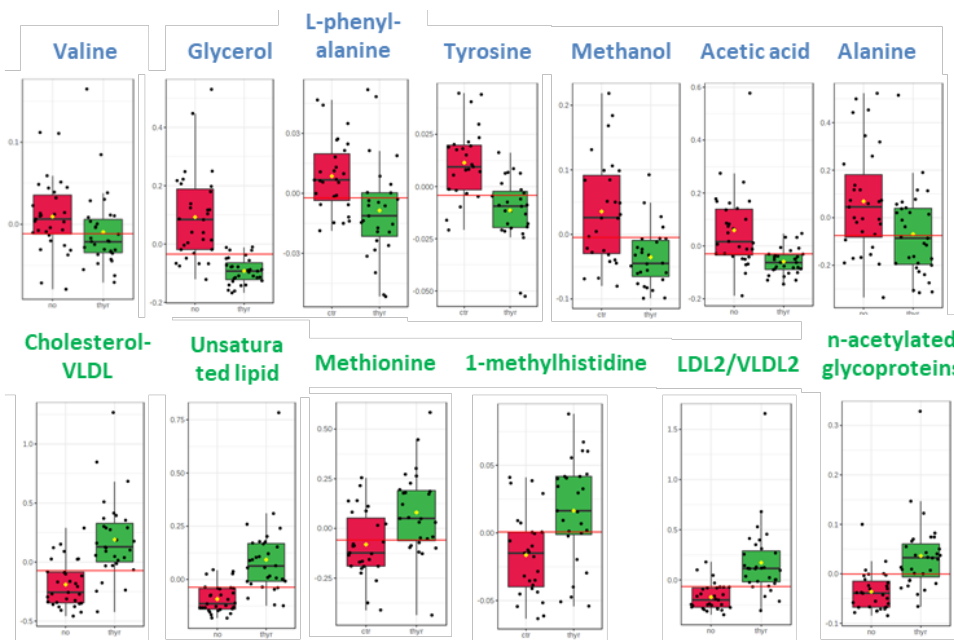
Figure 2. Box plots of discriminant metabolites in serum. (1. Valine, 2. Glycerol, 3. L-phenylalanine, 4. Tyrosine, 5. Methanol, 6. Acetic acid, 7. Alanine, 8. Cholesterol-VLDL, 9. Unsaturated lipid, 10. Methionine, 11. Methylhistidine, 12, LDL2/VLDL2, 13. n-acetylated glycoproteins). The circulatory metabolome was dominated by signals from lipids and lipoproteins.